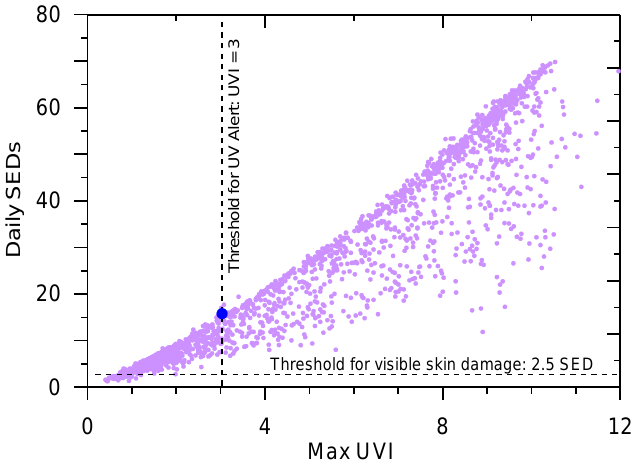
Figure 7. Daily dose of erythemal UV as a function of maximum UVI measured in Valladolid, Spain. The blue dot shows the mean SED for UVI = 3, calculated for clear days at the measurement station.